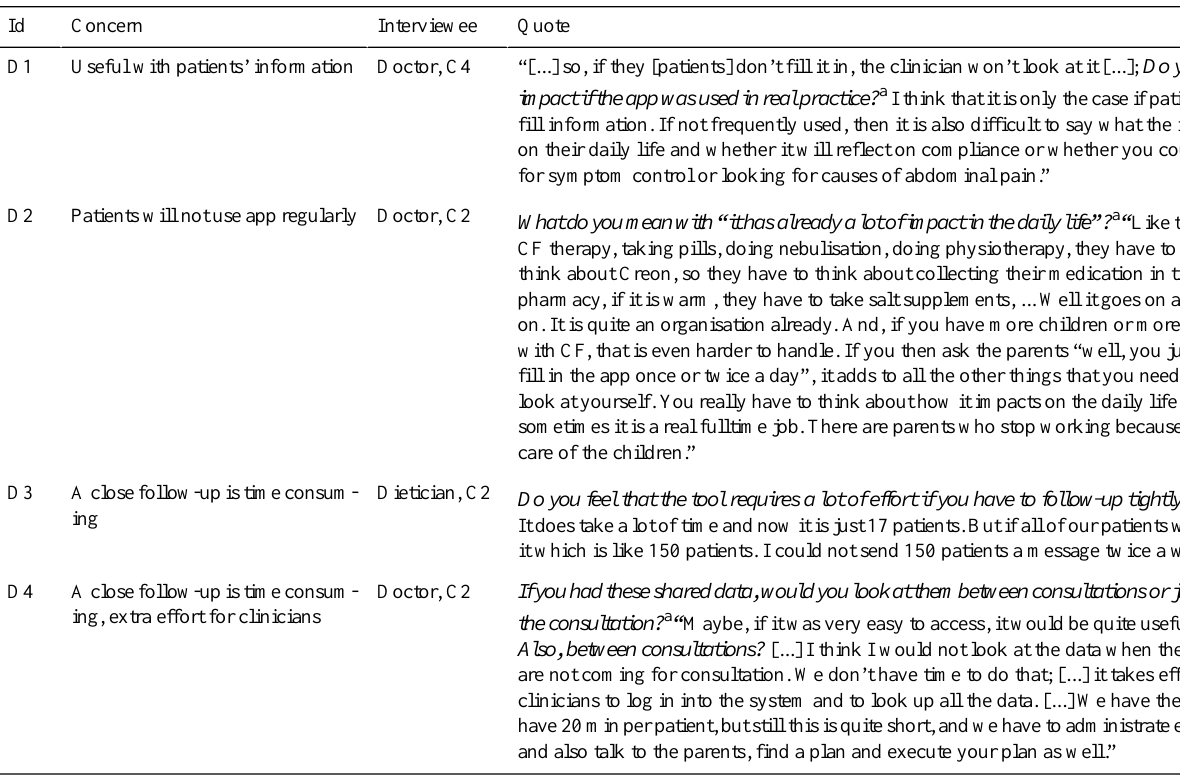
Table 11. Illustrative quotes related to using the professional web tool: perceived disadvantages.